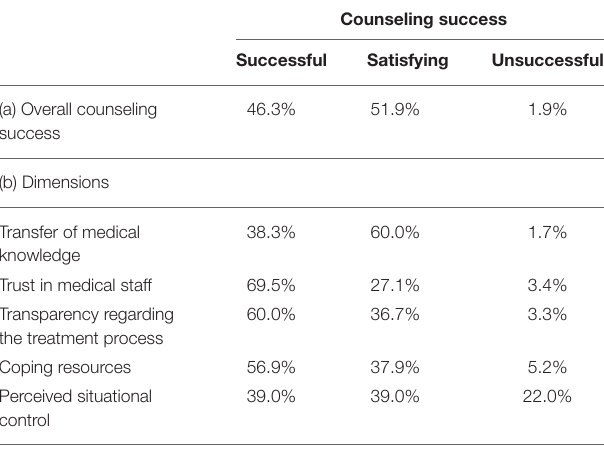
TABLE 2 | Counseling success in percent of total (a) “Overall Counseling Success” and (b) “Counseling Success” in the five analytical dimensions ( n =